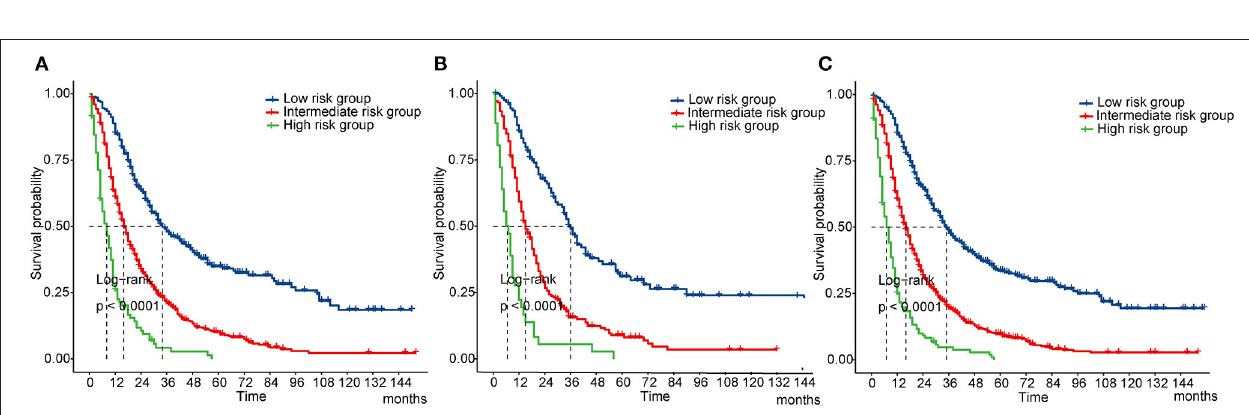
FIGURE 6 | Kaplan-Meier curves of OS for risk classification based on the nomogram scores. (A) In the training cohort; (B) In the validation cohort; (C) In all cohort. OS, overall survival.